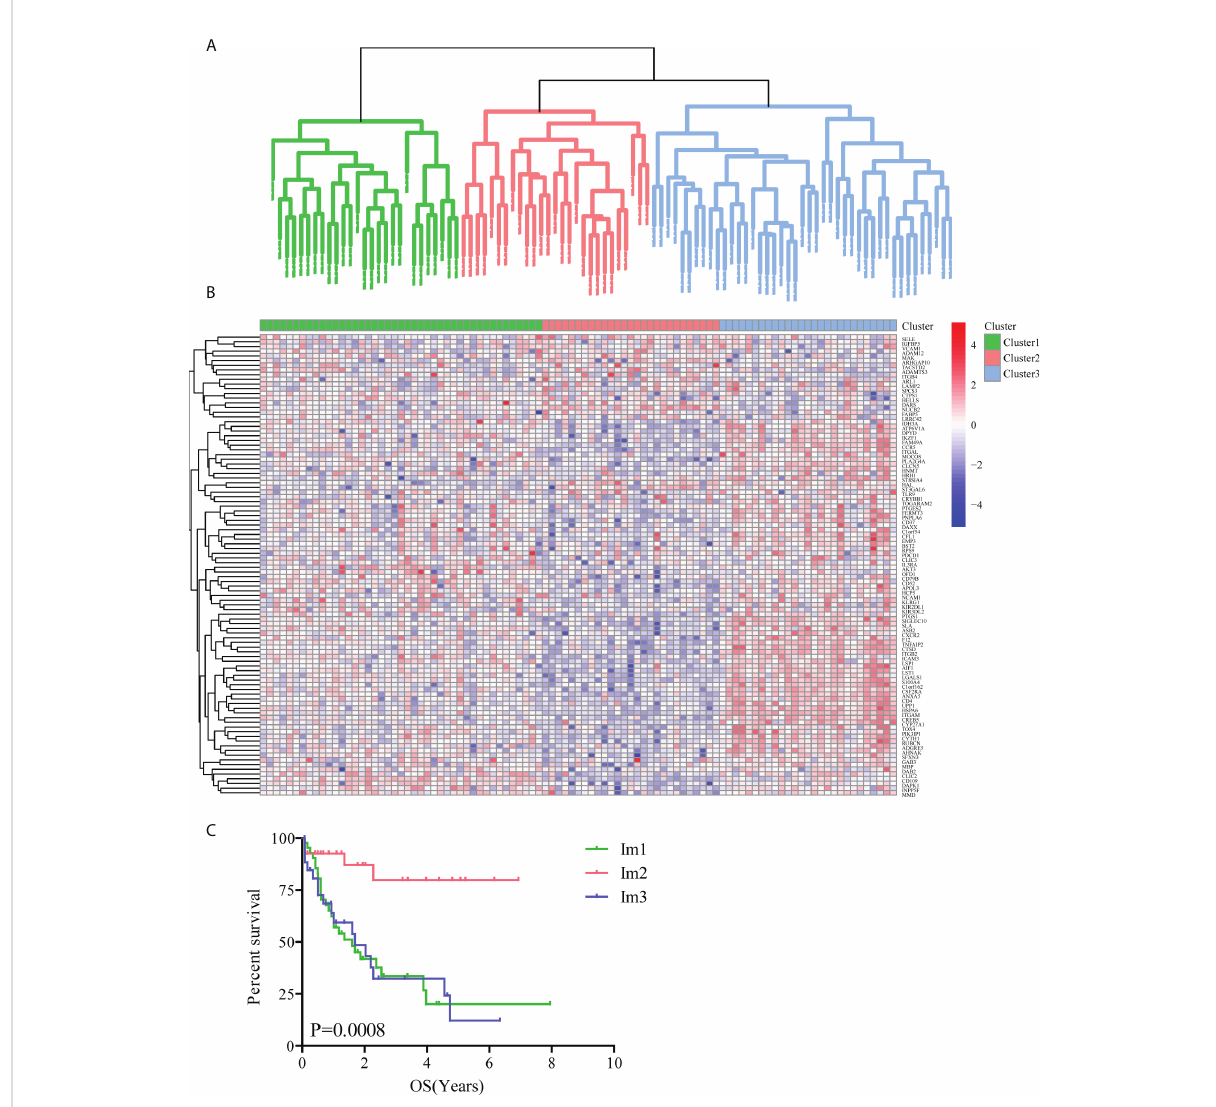
FIGURE 1 Unsupervised clustering analysis of AML patients based on 98 survival-related immune genes. (A) All 97 TCGA-AML patients were divided into 3 clusters (green: Im1 cluster, red: Im2 cluster, blue: Im3 cluster). (B) Heatmap of 98 survival-related immune genes in different AML clusters. (C) The Kaplan-Meier survival analyses along with the Log-rank test were used to compare the overall survival (OS) of the Im1, Im2 and Im3